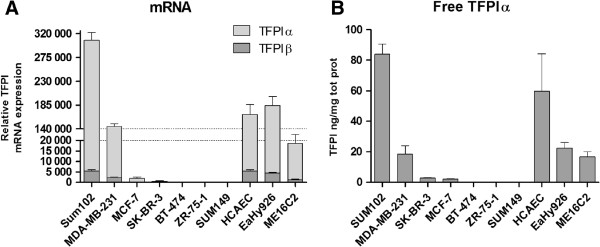
TFPI expression in different breast cancer cell lines and normal cells. Cells were seeded in 6-wells trays to reach ~80% confluence in three days before media were collected and cells lysed for RNA isolation. (A) Relative TFPIα and TFPIβ mRNA expression measured using qRT-PCR. ΔΔCt values were calculated using 18s rRNA as an endogenous control and the TFPI negative, non-human CHO cells as a negative control. (B) Secreted TFPIα protein measured in cell media and normalized to total protein amounts. Mean values + SD (n = 3) are presented.